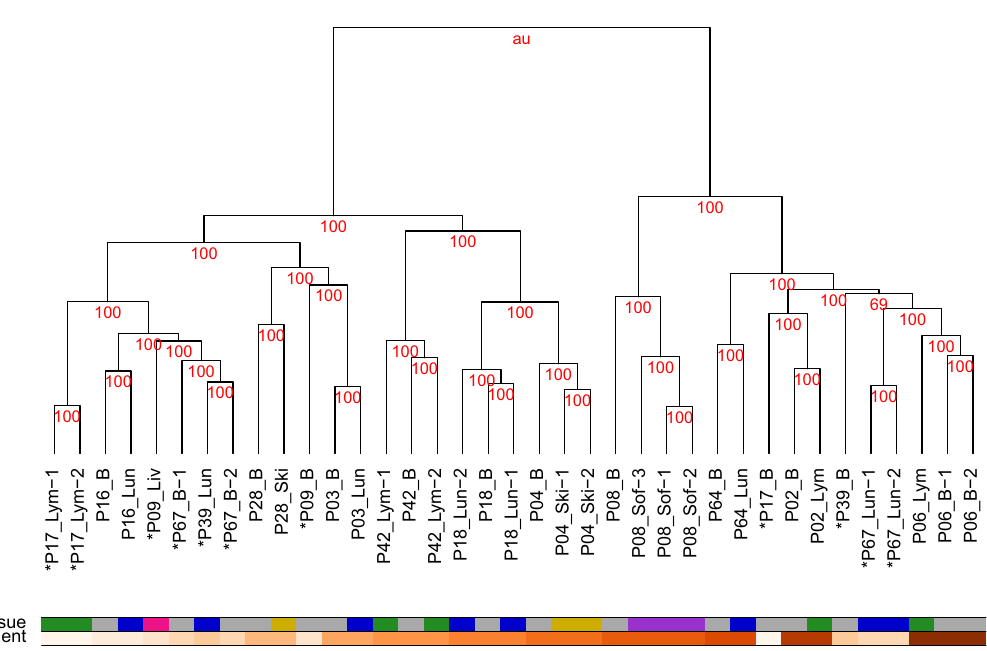
Figure 1. Similarity of methylomes of patient-specific melanoma metastases. Hierarchical clustering of genome-wide methylation profiles of 16 intra- and 21 extracranial metastases from 14 patients (Table 1). Patient-specific metastasis samples are co-clustered together in almost all cases independent of the tissue type in which the metastases were located. This patient-specific rather than tissue-specific clustering of melanoma metastases is given by the order of the metastases labels and illustrated by the patient color gradient below the dendrogram. The samples of four patients that did not cluster together are marked by an asterisk ‘*’. Different tissues from which the metastases were taken are encoded in the metastases labels and highlighted by the tissue color code below the dendrogram (grey: brain, green: lymph node, blue: lung, pink: liver, yellow: skin, purple: soft tissue). The red number above each subcluster in the dendrogram represents the approximate unbiased p value (AU value) determined by bootstrapping, where a value of 100 means that the corresponding subcluster was completely